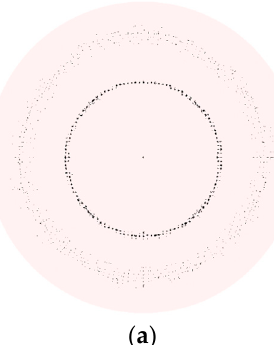
Figure 2. The collection efficiency obtained by the simulated results from CFD-DPM method and CFD-DEM method and experiment data [34].